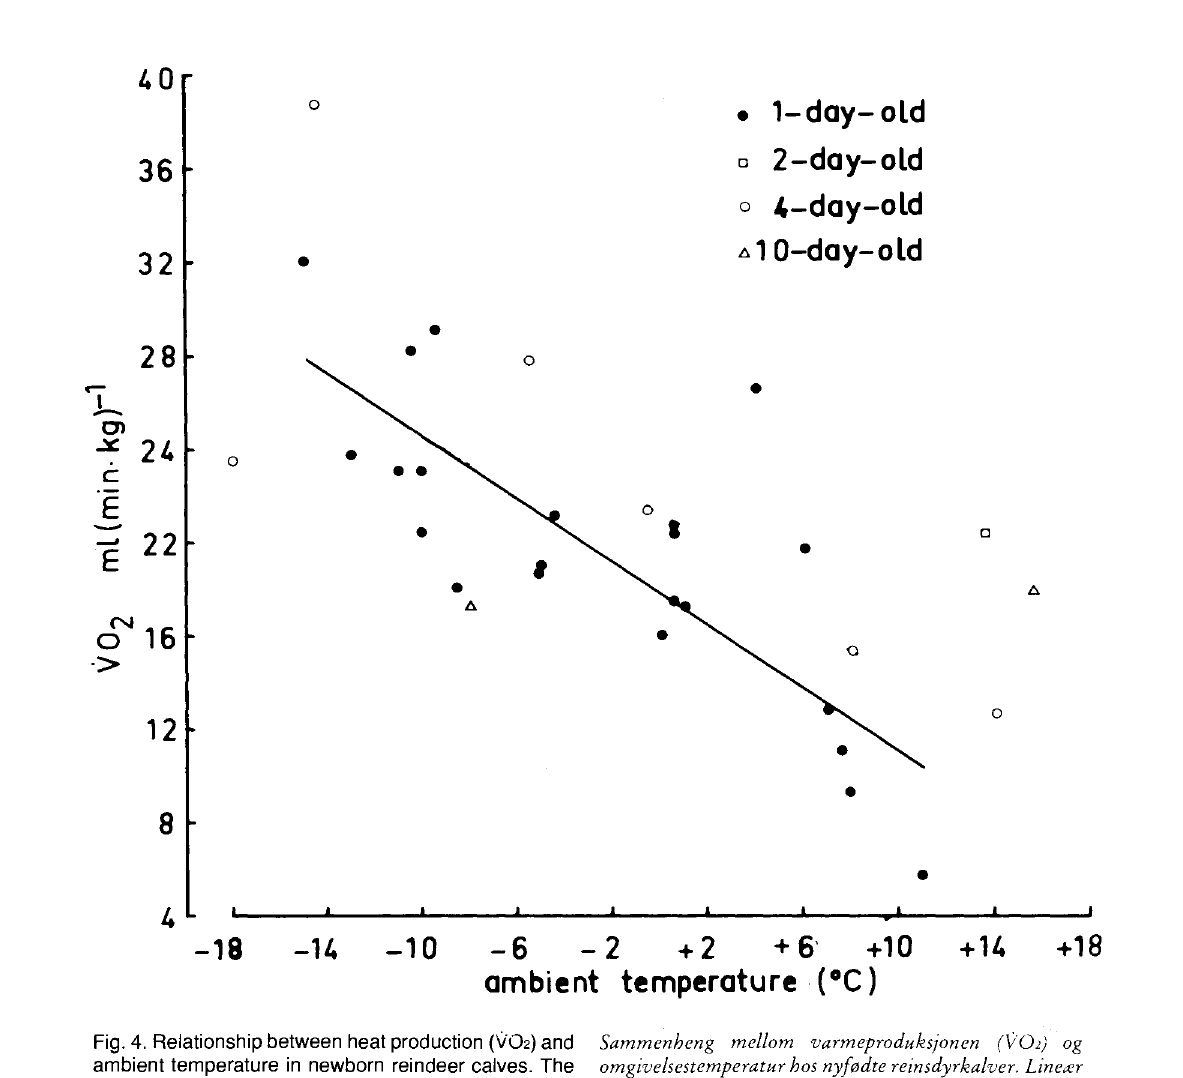
omgivelsestemperatur hos nyfødte reinsdyrkalver.